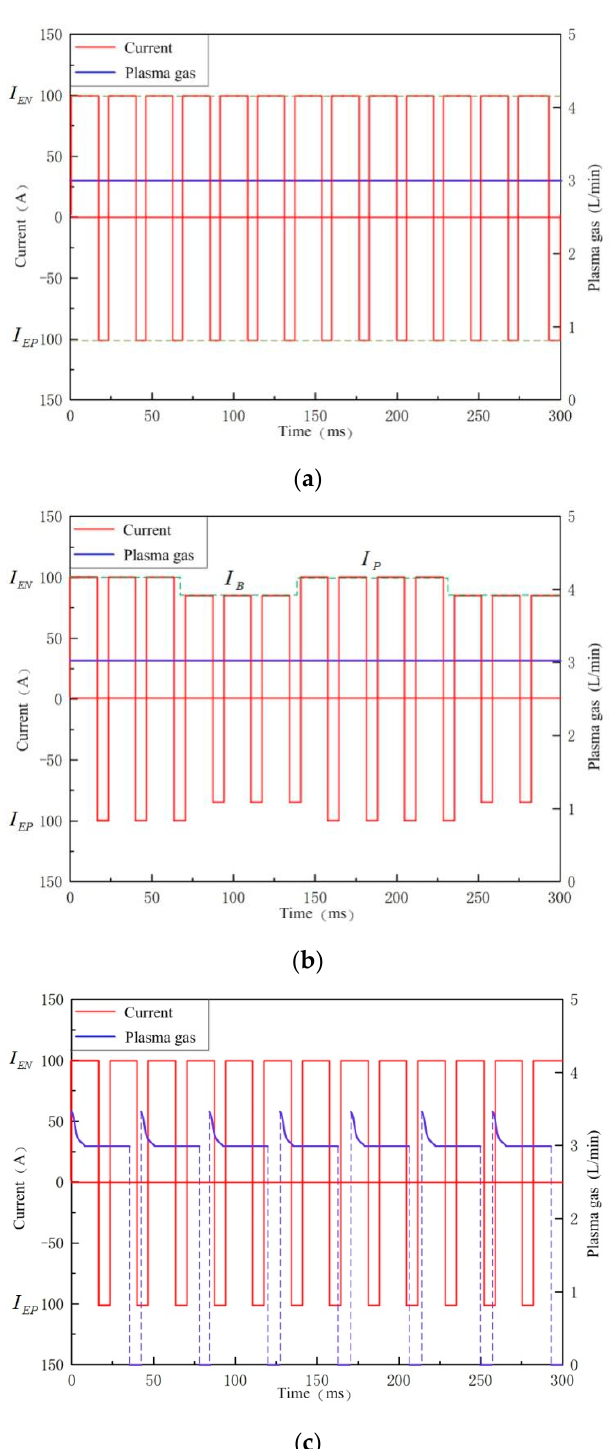
Figure 3. Schematic diagram of current–plasma gas flow waveform. ( a ) VPPAW; ( b ) DP-VPPAW; ( c ) PPG-VPPAW. Table 1. Parameters for arc image and electrical signal comparison.